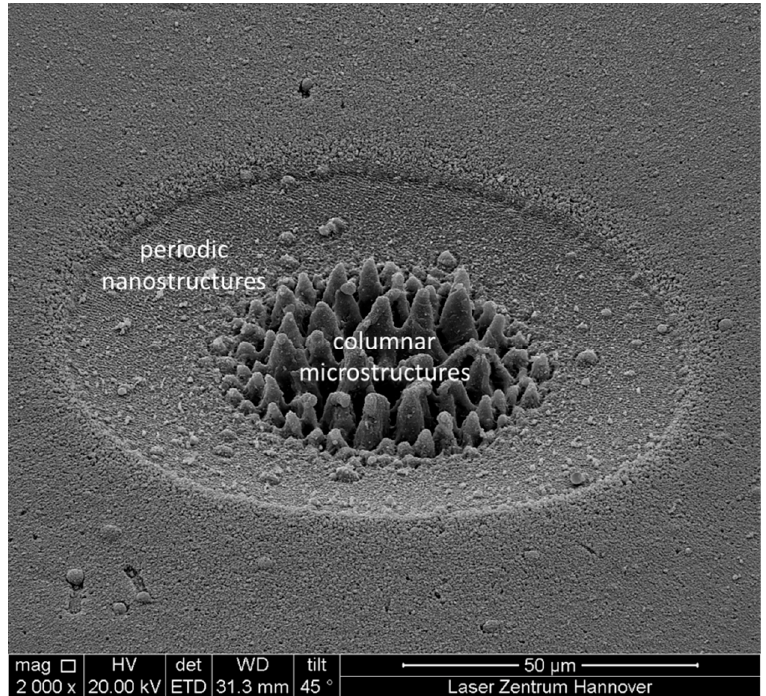
Figure 4. Titanium surfaces after irradiation at 2.5 J/cm² with 100 laser pulses (stationary conditions): columnar structure (in the center of the ablation crater), periodic nanostructure (in the outer region of the ablation crater).